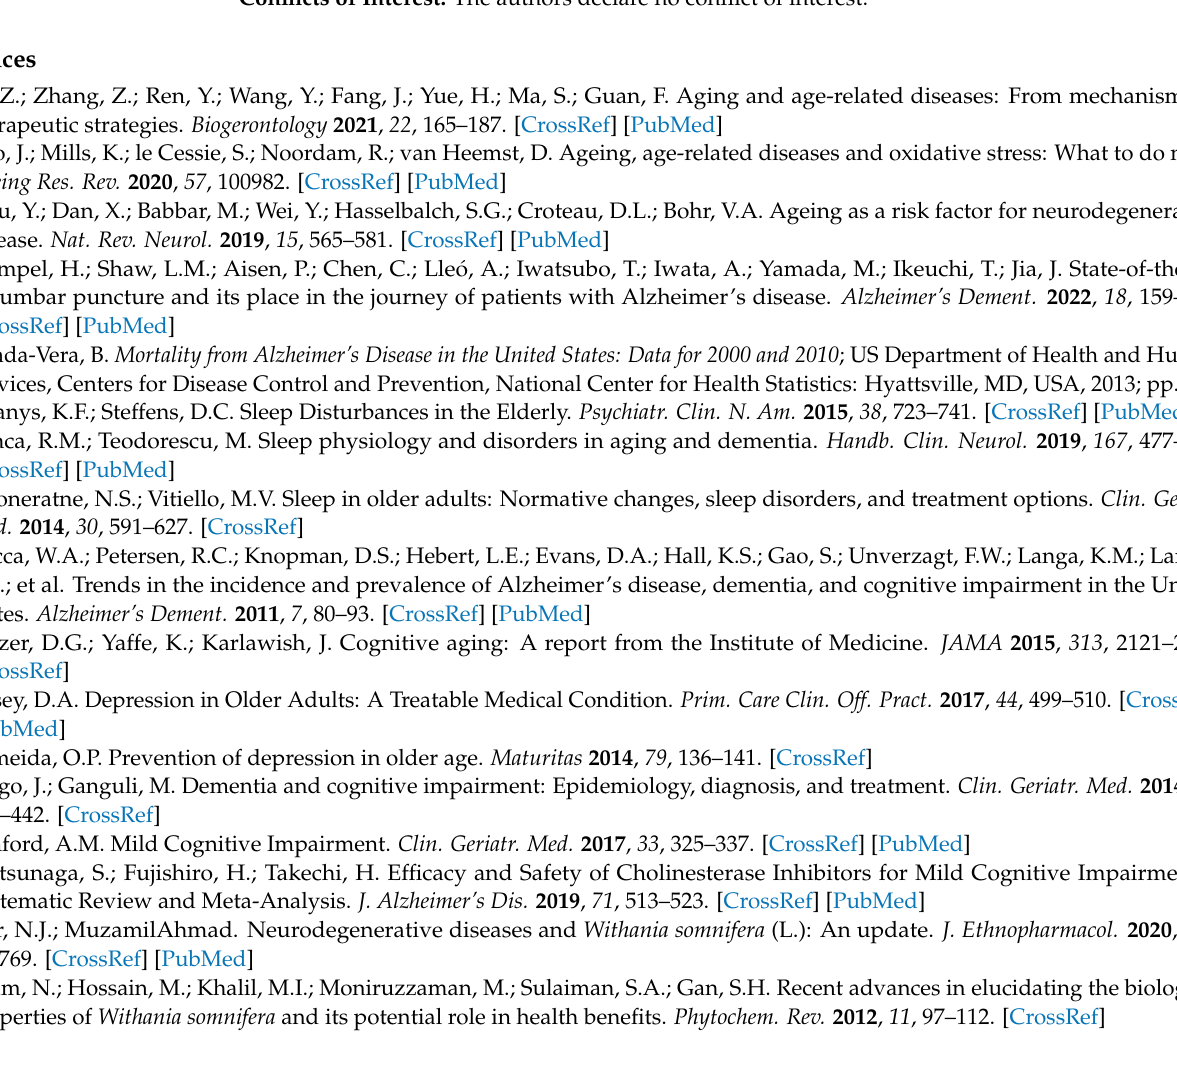
feeding of WSE-2 improves sleep in males but not in